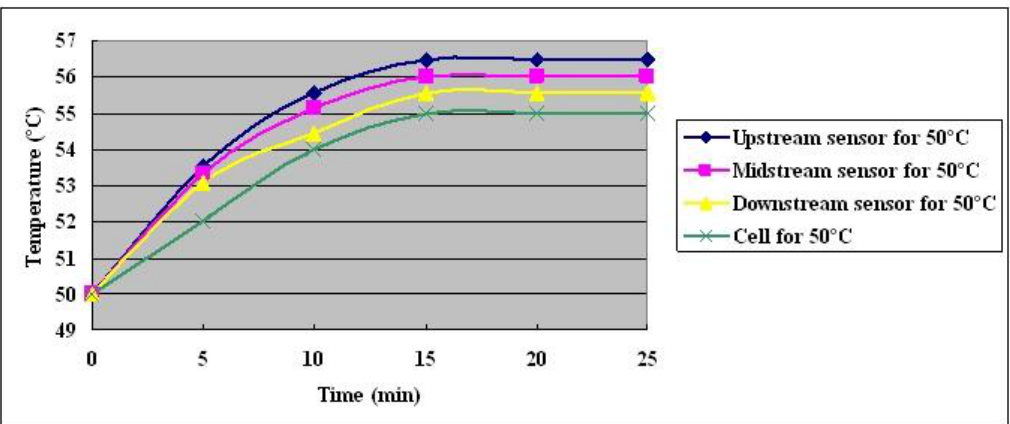
Figure 11. Temperature distributions at cell temperature of 50  C with constant output current of 25